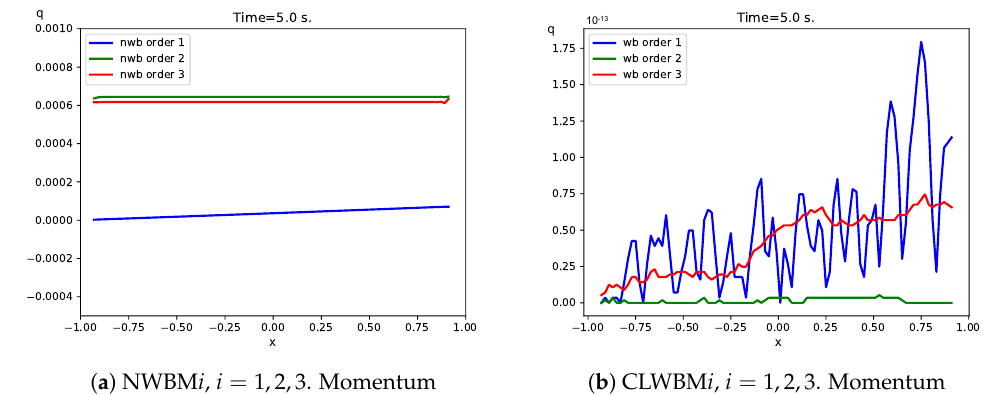
Figure 15. Test 5.1. Differences between the stationary and the numerical solutions at time t = 5 s for q with a mesh of 100 cells.